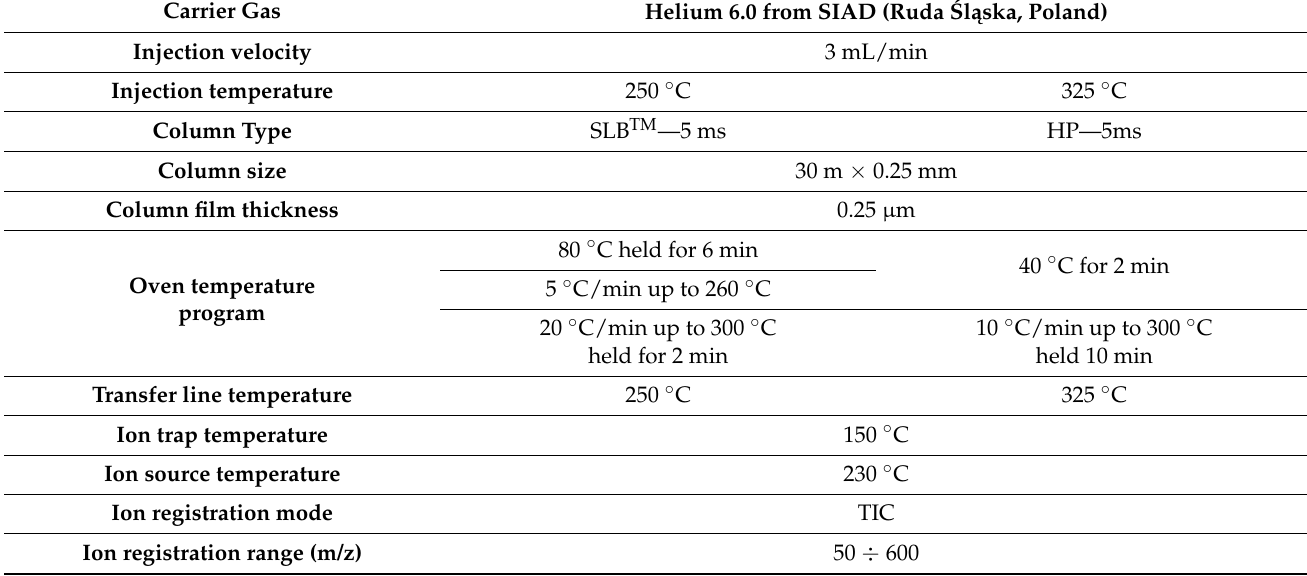
Table 3. Conditions of chromatographic